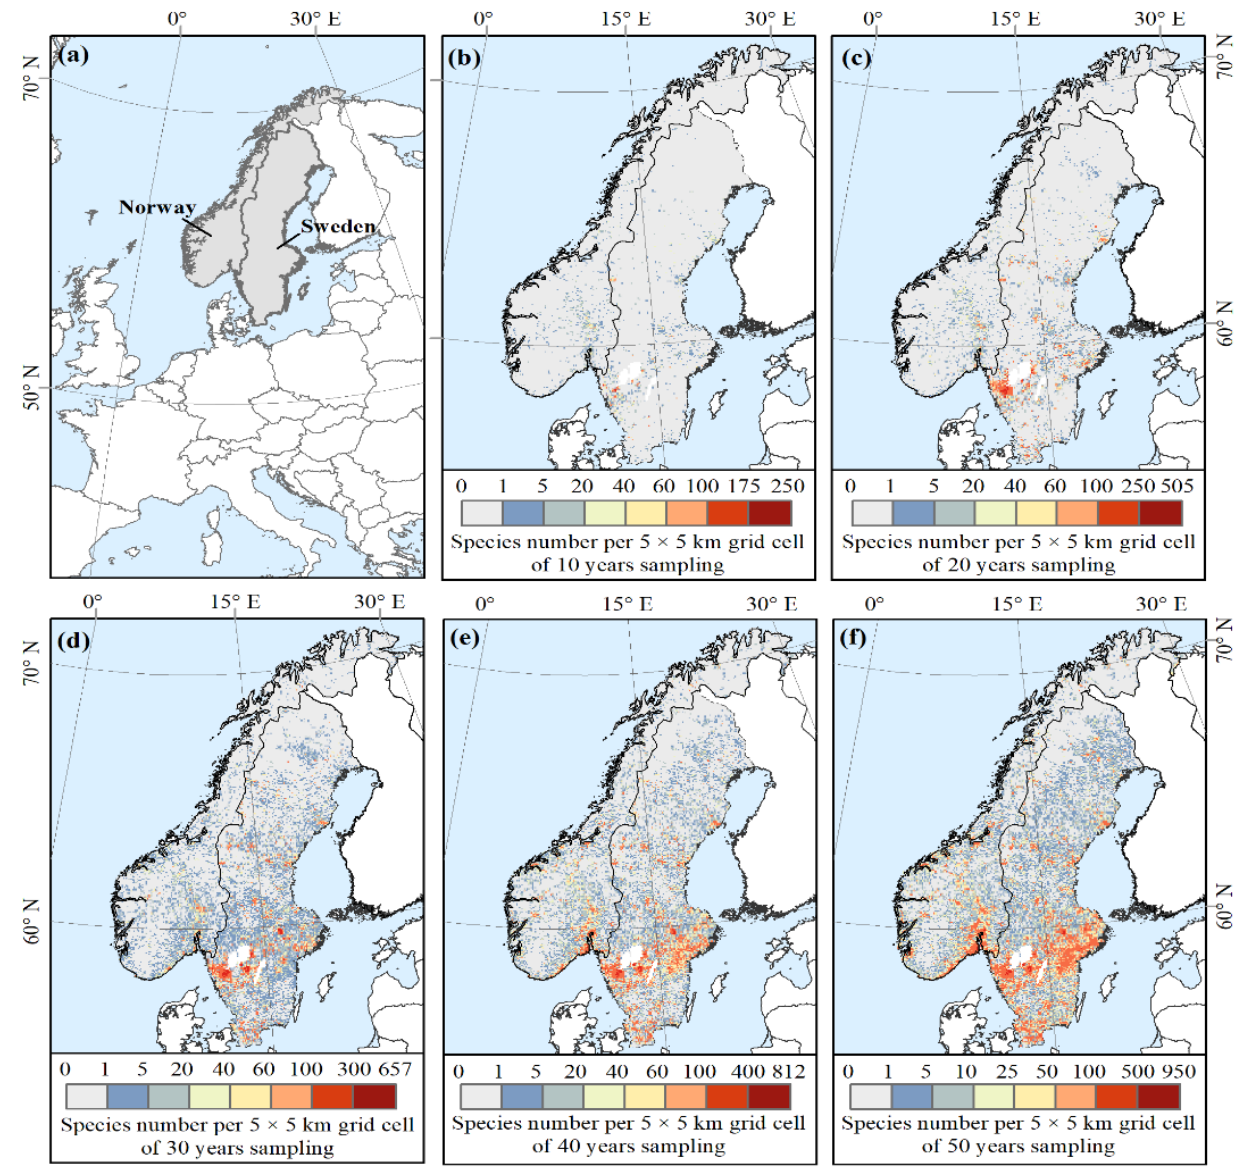
Figure 2. Location of the study area ( a ) and the distribution of the number of macrofungal species per grid cell used in this study for ( b ) 10 years (1970–1980), ( c ) 20 years (1970–1990), ( d ) 30 years (1970–2000), ( e ) 40 years (1970–2010), and ( f ) 50 years (1970–2020) sampling.